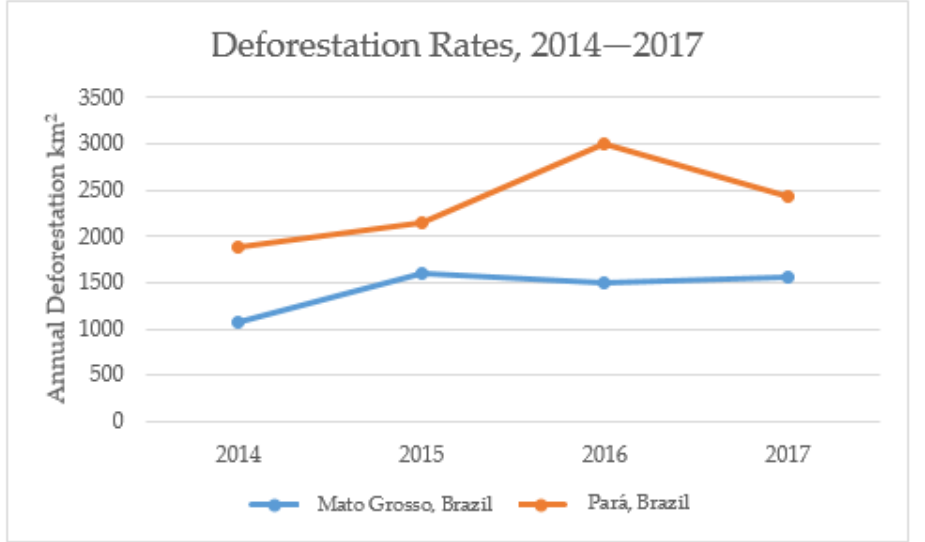
Figure A1. Deforestation rates for Mato Grosso and Pará, Brazil between 2014 and 2017.